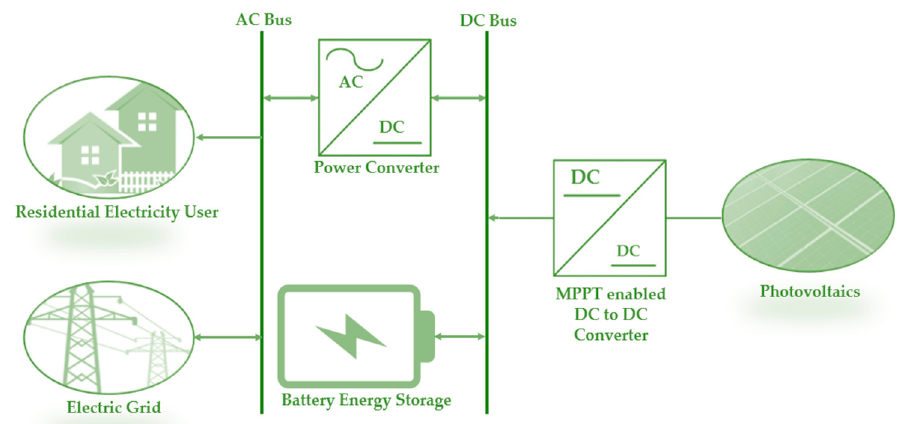
Figure 7. Schematic view of EG + PV + BES based power supply system configuration [Note: EG—